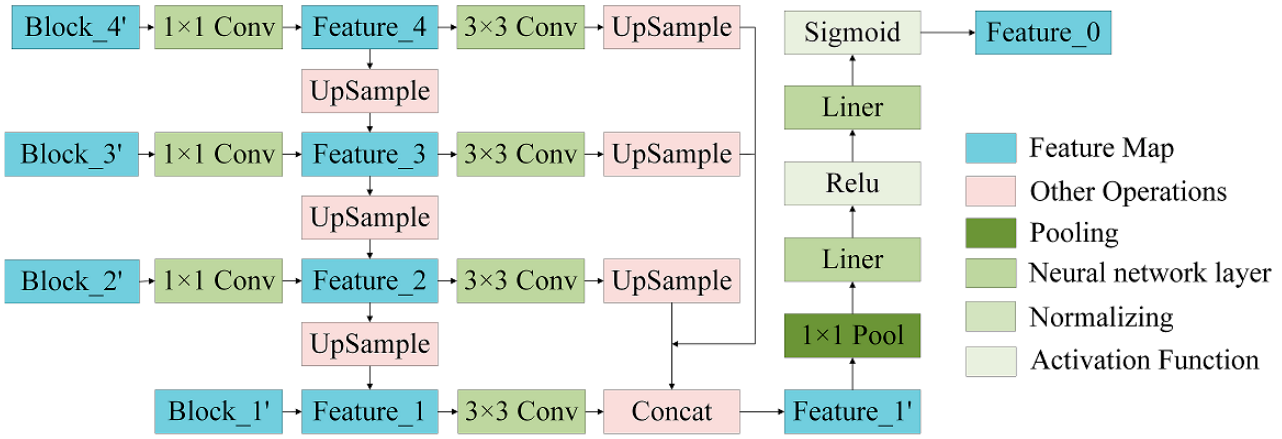
Figure 3. The detailed structure of the Multi-scale Feature Fusion (MFF).